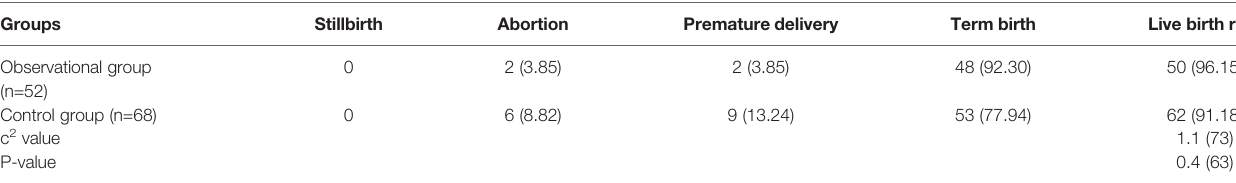
TABLE 5 | Comparison of pregnancy outcomes between the two groups (n, %). Groups